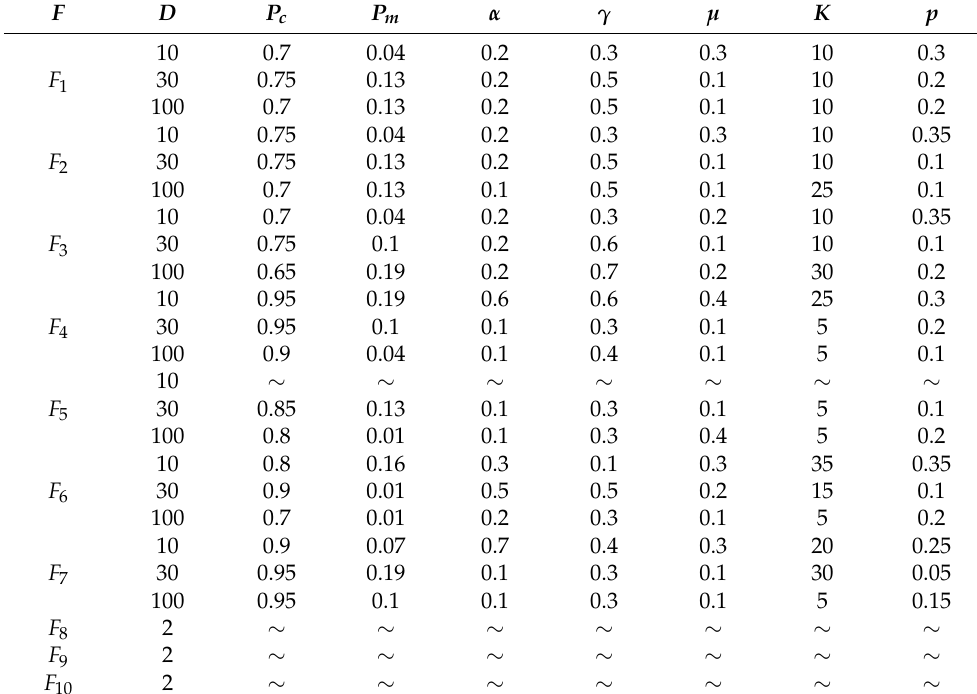
Table 5. Best parameters ( B–P ) of orthogonal